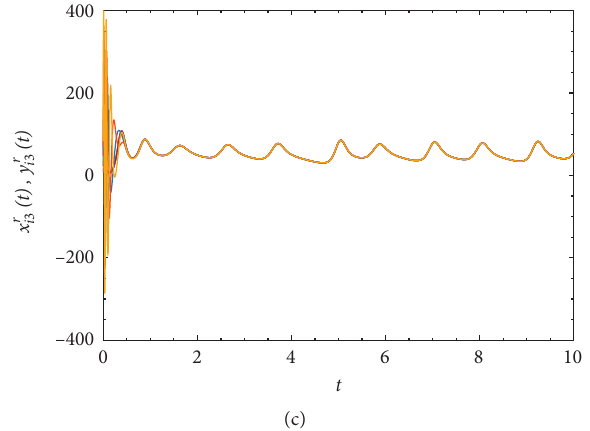
Figure 3: The evolution of x